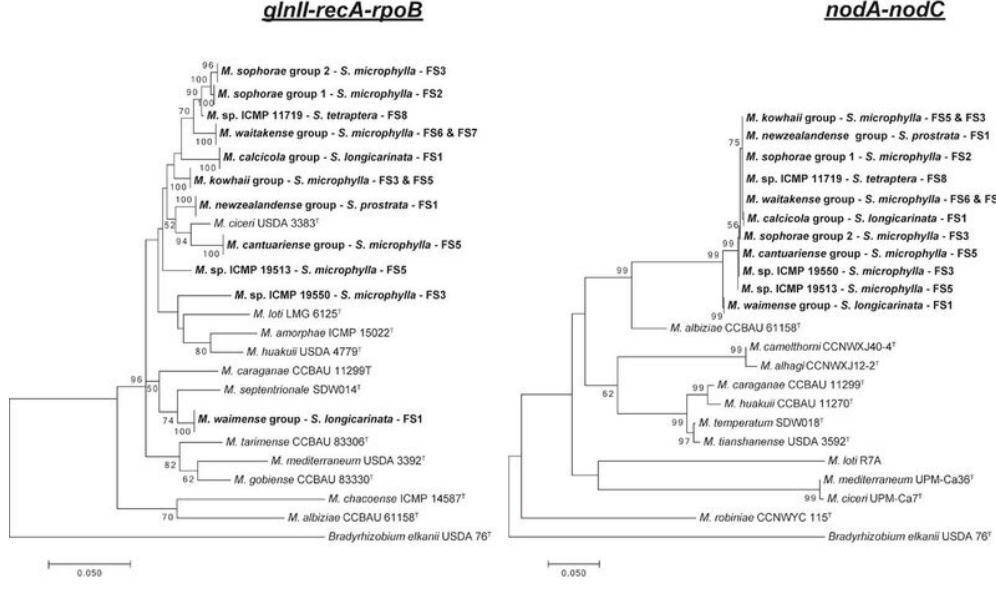
Figure 1. Comparative maximum likelihood phylogenetic analysis using housekeeping and symbiotic gene clusters from Mesorhizobium strains isolated from New Zealand endemic Sophora spp. Sequence alignment, alignment editing, and phylogenetic analysis were performed using MEGA7 [24]. The phylogenetic trees were built using the GTR model with G + I substitutions for the housekeeping genes (1083 bp) and Tamura 3-parameter model with G + I substitutions for the symbiosis genes (869 bp). The possibility of concatenation was investigated using the partition-homogeneity test with PAUP [25,26]. Each concatenation was investigated for 1000 replicates. All housekeeping genes were congruent with each other ( p = 0.015), and both symbiosis genes were congruent with each other ( p = 0.02). The housekeeping genes were shown not to be congruent with the symbiosis genes ( p = 0.001). Bootstrap values after 500 replicates are expressed as percentages; values less than 50% are not shown. The scale bar indicates the fraction of substitutions per site. M: Mesorhizobium , S: Sophora , FS: Field Site.